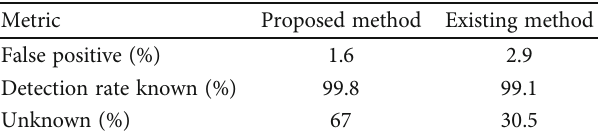
Table 3: Matrix comparison table between the existing and proposed